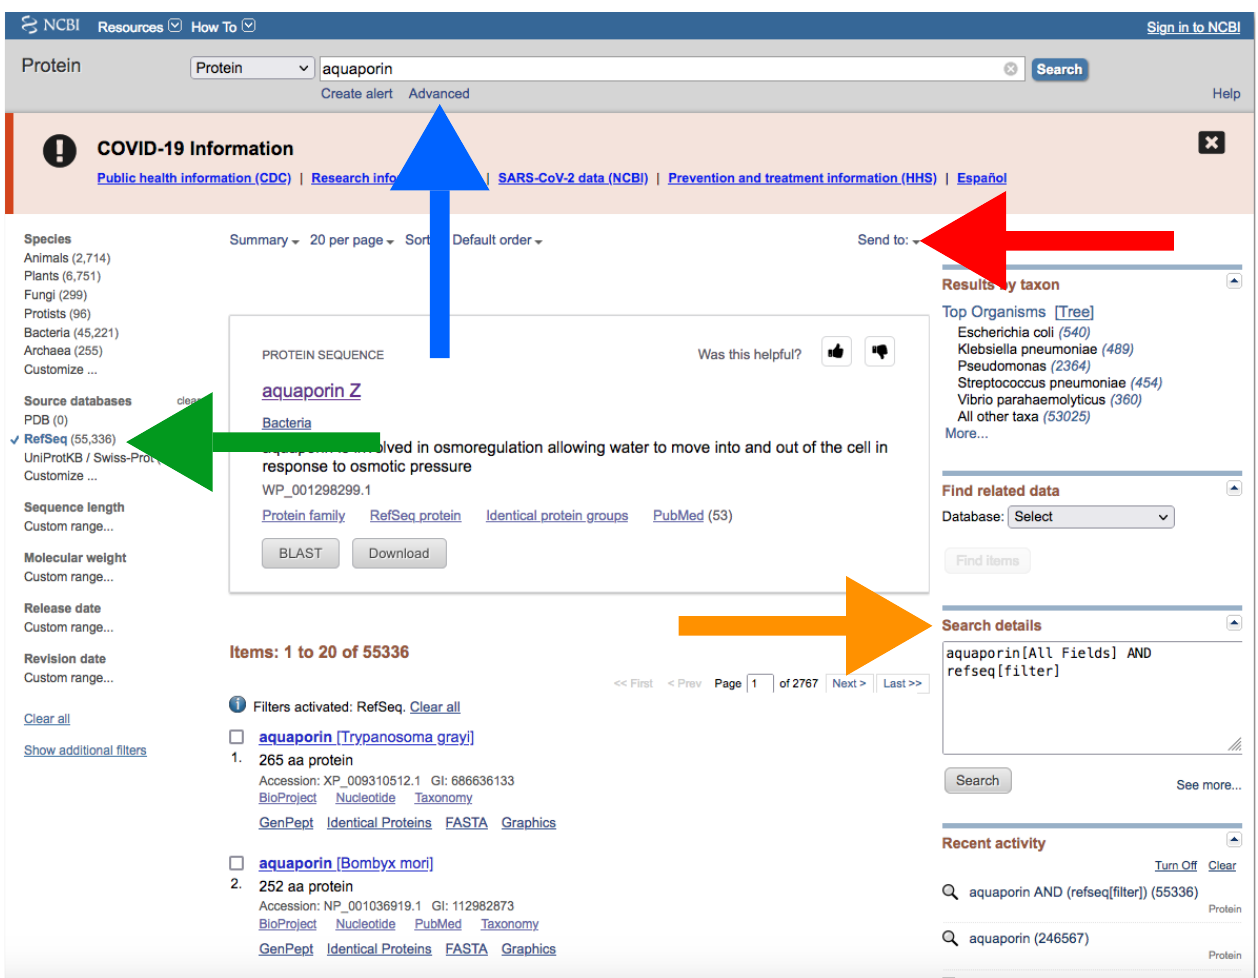
Figure 7. The NCBI web server interface after search in the protein database. The blue arrow indicates the search box; the green arrow and green square indicate “RefSeq” and the filters side bar, respectively; the orange arrow indicates “Search details”, and the red arrow button and red square indicate the “Send to” button and the “Create file” window for downloading, respectively. Accessed on 27 January 2022.